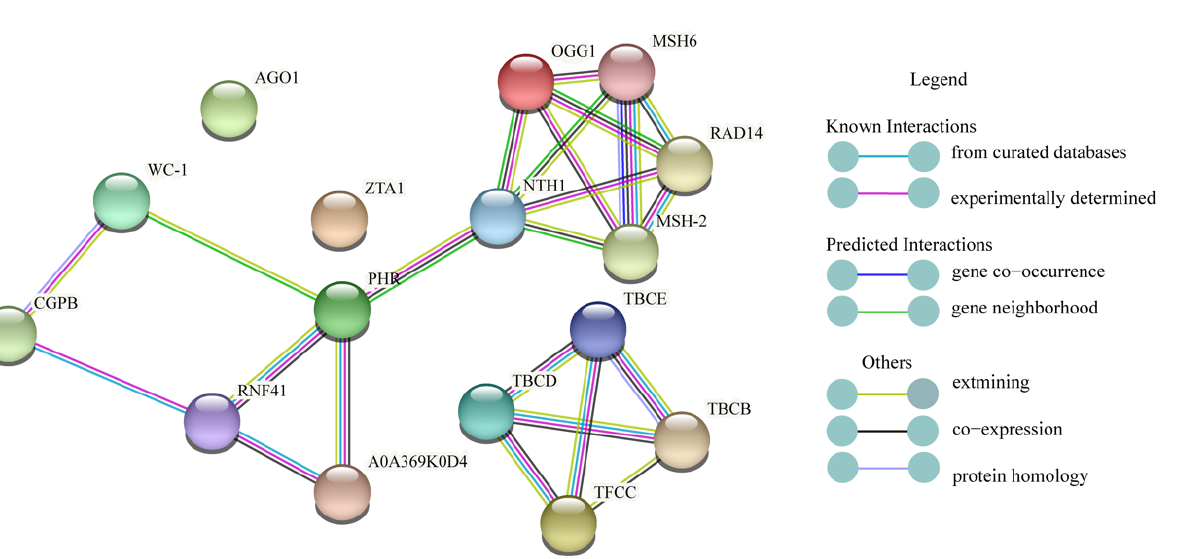
Figure 10. Protein-protein interaction network.